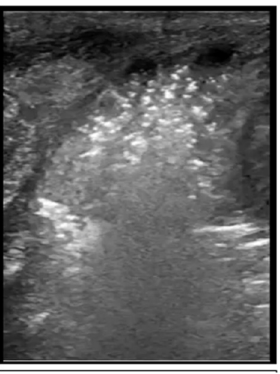
Figure 7. Pulmonary hemorrhage in B-mode.